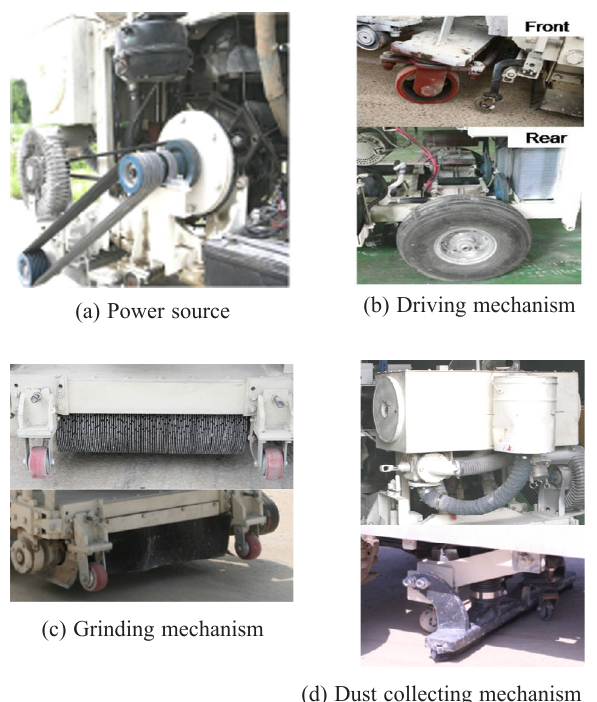
Fig. 3. Prototype hardware system components